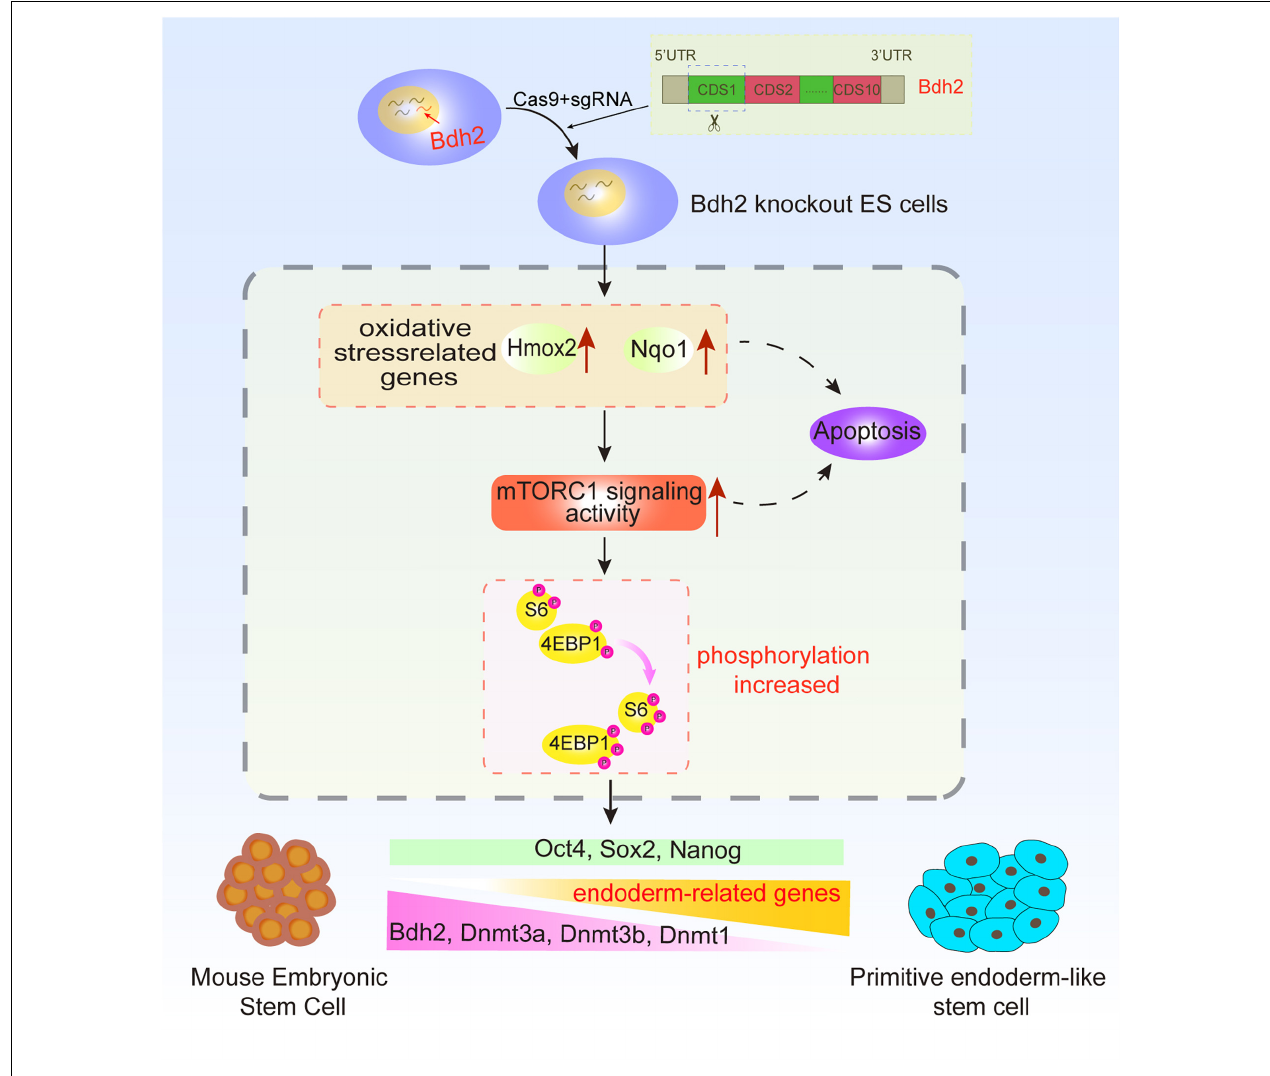
FIGURE 6 | Summary